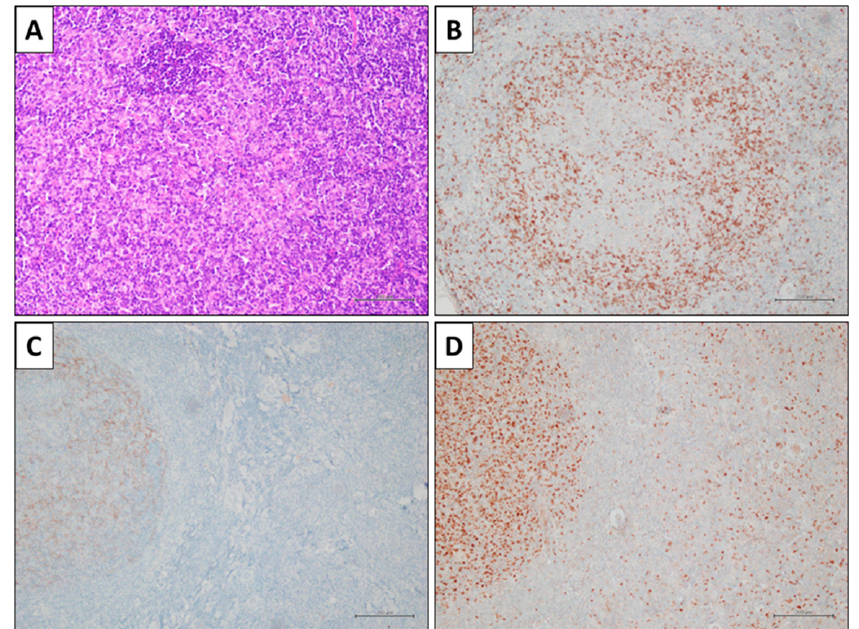
Figure 4. Diagnostic utility of follicle center ( A ) in PCFCL. ( B ) IgD immunohistochemistry showing a